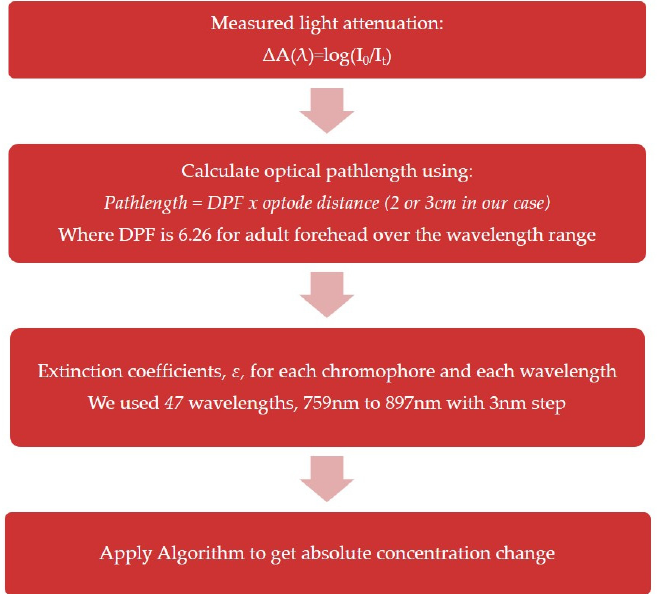
Figure 6. Flow chart or block diagram of algorithm used to extract HbO, HbR, and CCO from the wavelength-dependent measurements (following [37,38]).